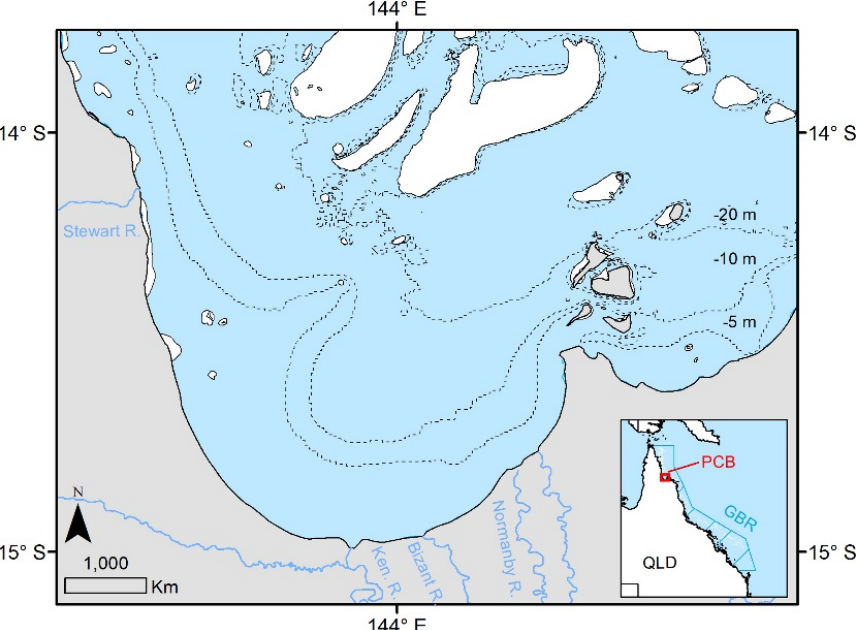
Figure 1. Location map and bathymetry of Princess Charlotte Bay (PCB). White areas indicate submerged reefs, blue lines indicate river systems, and dotted black lines indicate bathymetry contours. The insert shows the location of PCB relatively to the Great Barrier Reef (GBR).